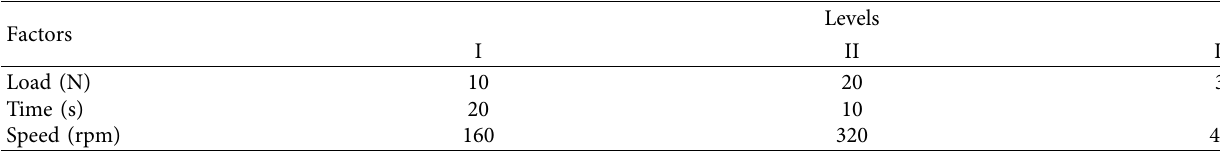
Table 2: Control factors and levels for dry sliding wear test.